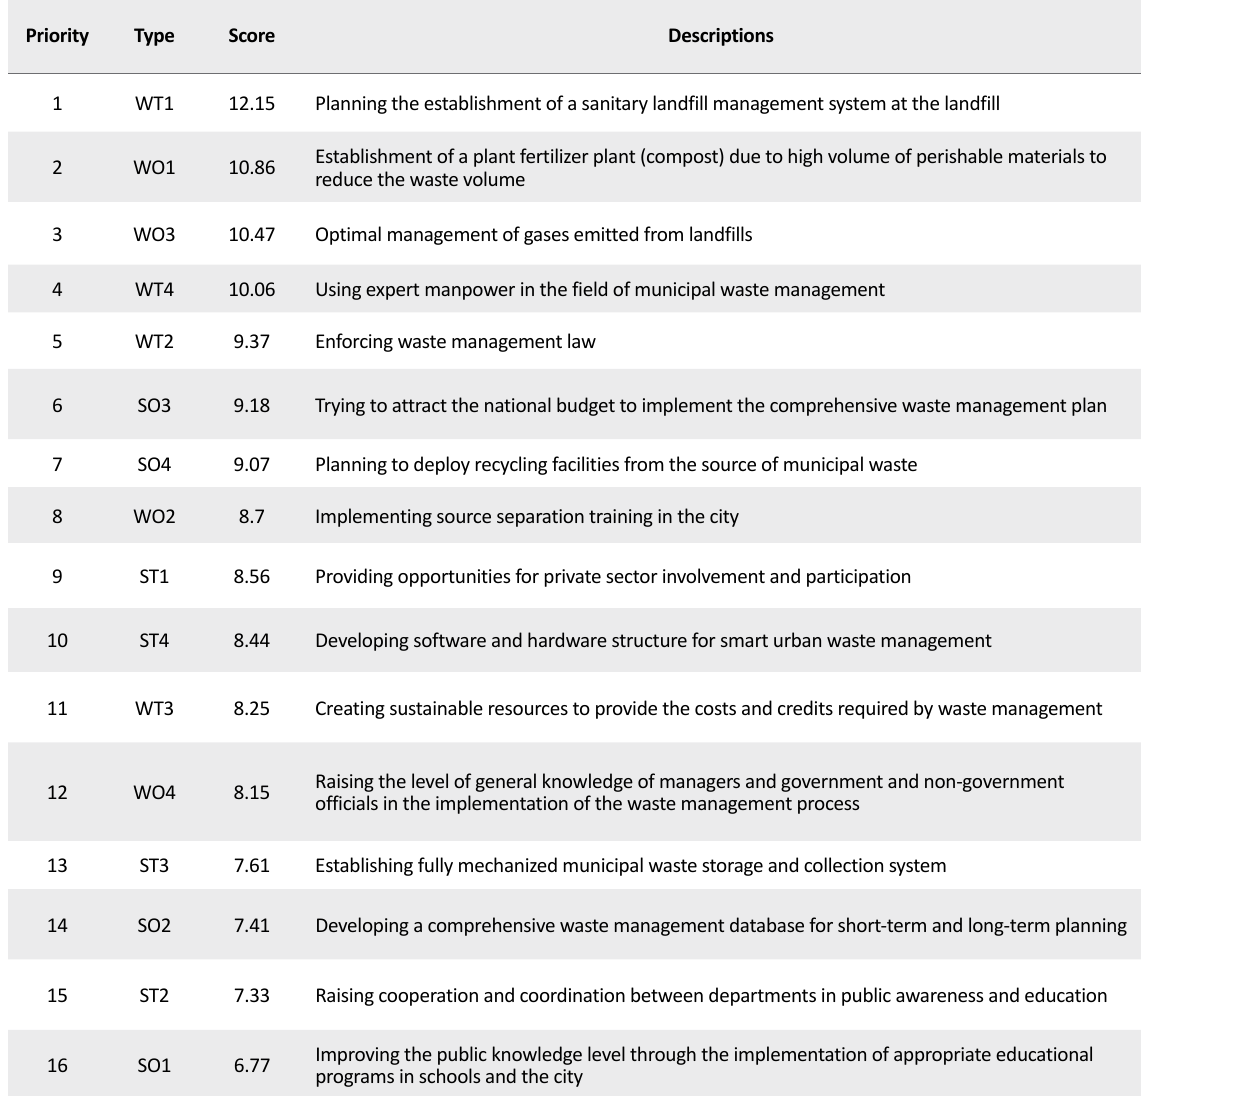
Table 5. Priorities identified for municipal waste management strategies using QSPM